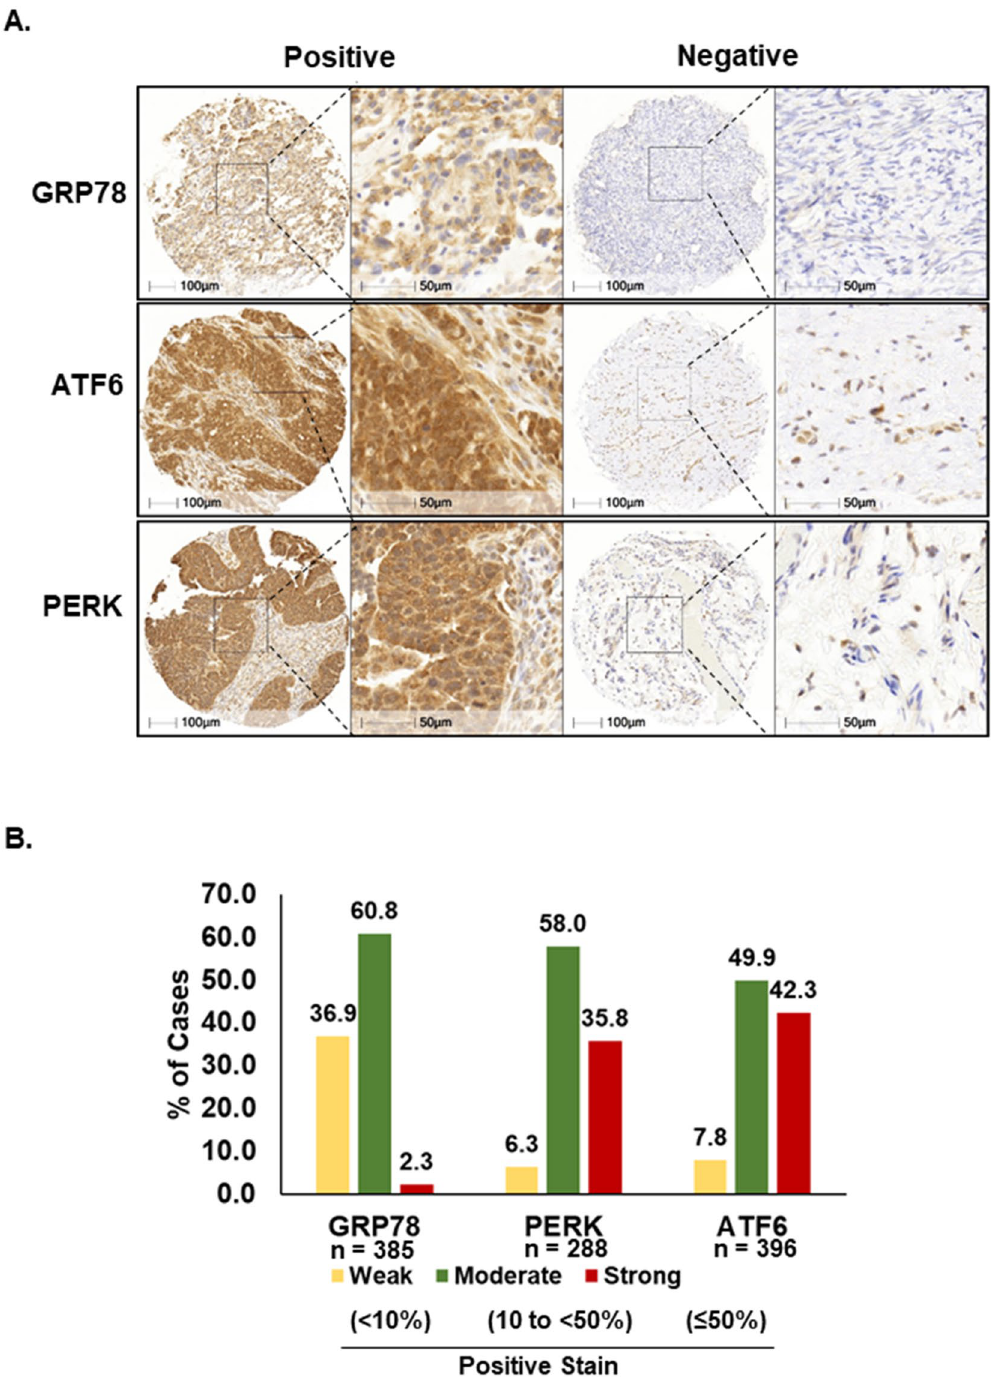
Figure 2. Immunohistochemical expression patterns of ER stress-associated proteins in ovarian cancer tissues. ( A ) Representative examples of positive and negative/weak staining patterns of GRP78, ATF6, and PERK in ovarian cancer tissues. ( B ) Percent of cases of strong ( ≥ 50%), moderate (10 to < 50%), and weak ( < 10%) expression for each protein are shown. Percent of staining was automatically quantified by HALO (Indica labs, New Mexico,